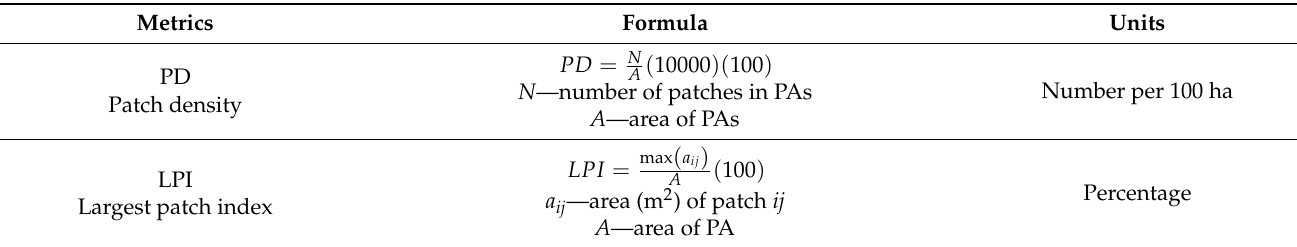
Table A2. Landscape metrics with pairwise correlations less than